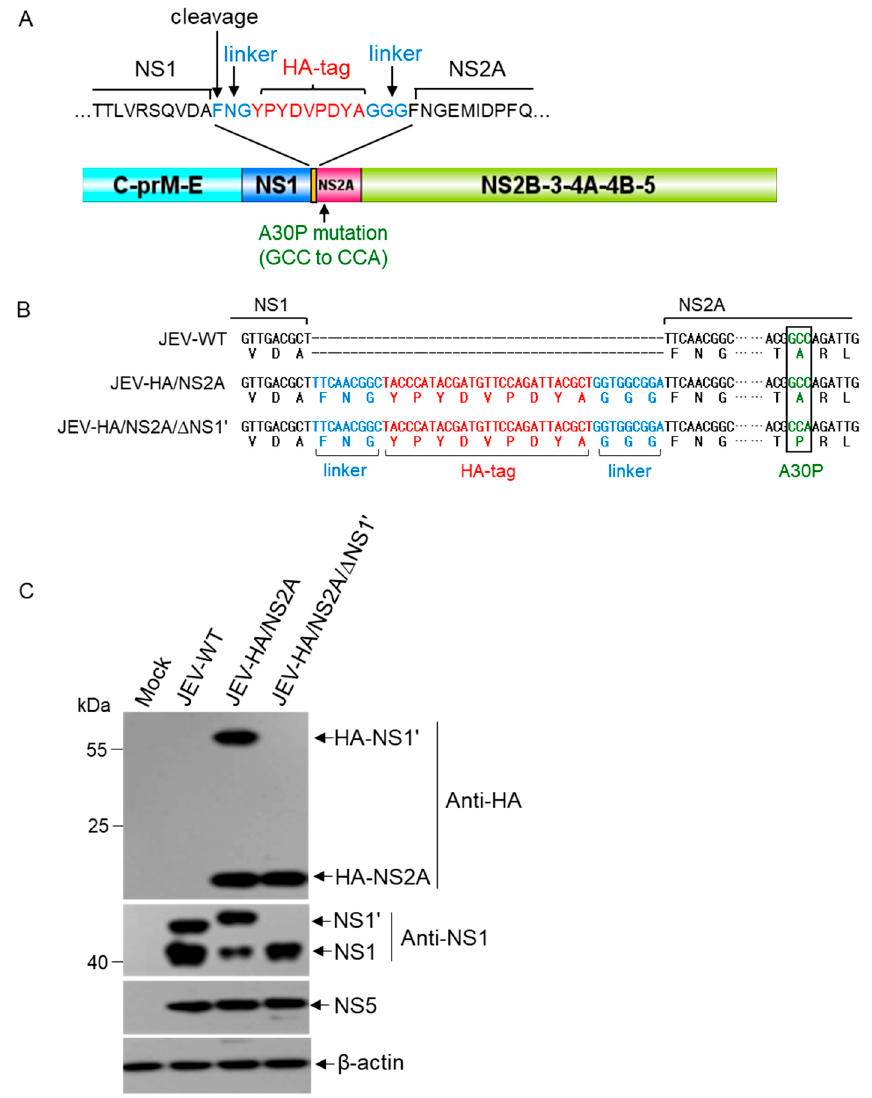
Figure 1. Construction of recombinant JEV with HA-tagged NS2A. ( A ) Schematic diagram of recombinant JEV with HA-tagged NS2A. ( B ) HA-tag, linkers, and A30P mutation sequences. ( C ) Detection of HA-NS2A expression by western blotting. BHK-21 cells were infected with the recombinant JEV and harvested for analysis of viral protein expression by western blotting.